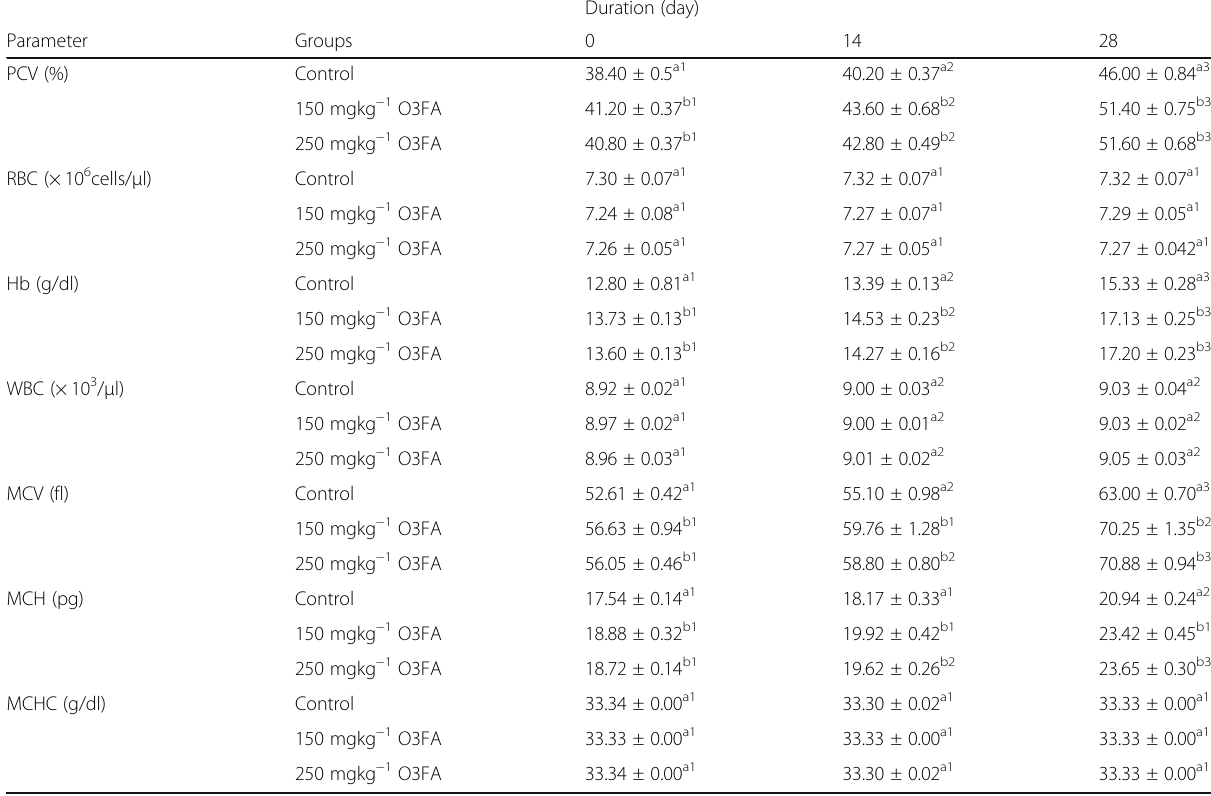
Table 1 Effects of O3FAs on haematological indices in male rats